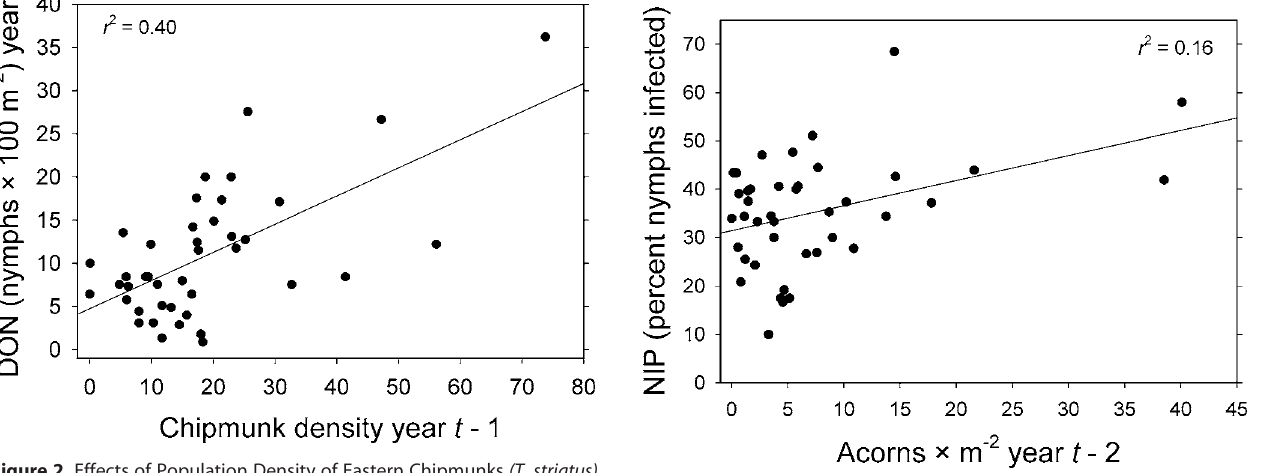
Figure 2. Effects of Population Density of Eastern Chipmunks (T. striatus) on DON Shows relationship between number of chipmunks per 2.25-ha grid in year t (cid:1) 1 and DON (number per 100 m 2 ) in year t. This regression model for DON had the most support. DOI: 10.1371/journal.pbio.0040145.g002 PLoS Biology |